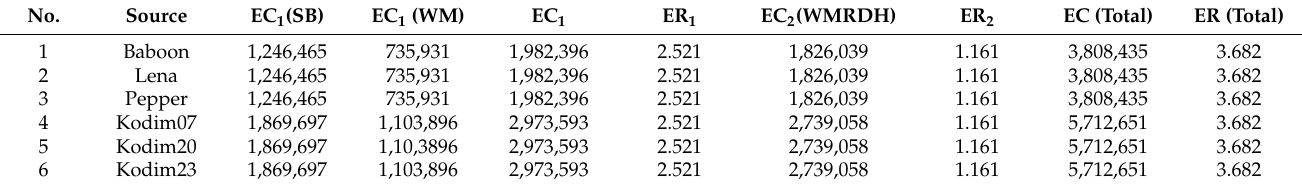
Table 7. The embedding capacities and embedding rates in Phase-1 (SB+WM) and Phase-2